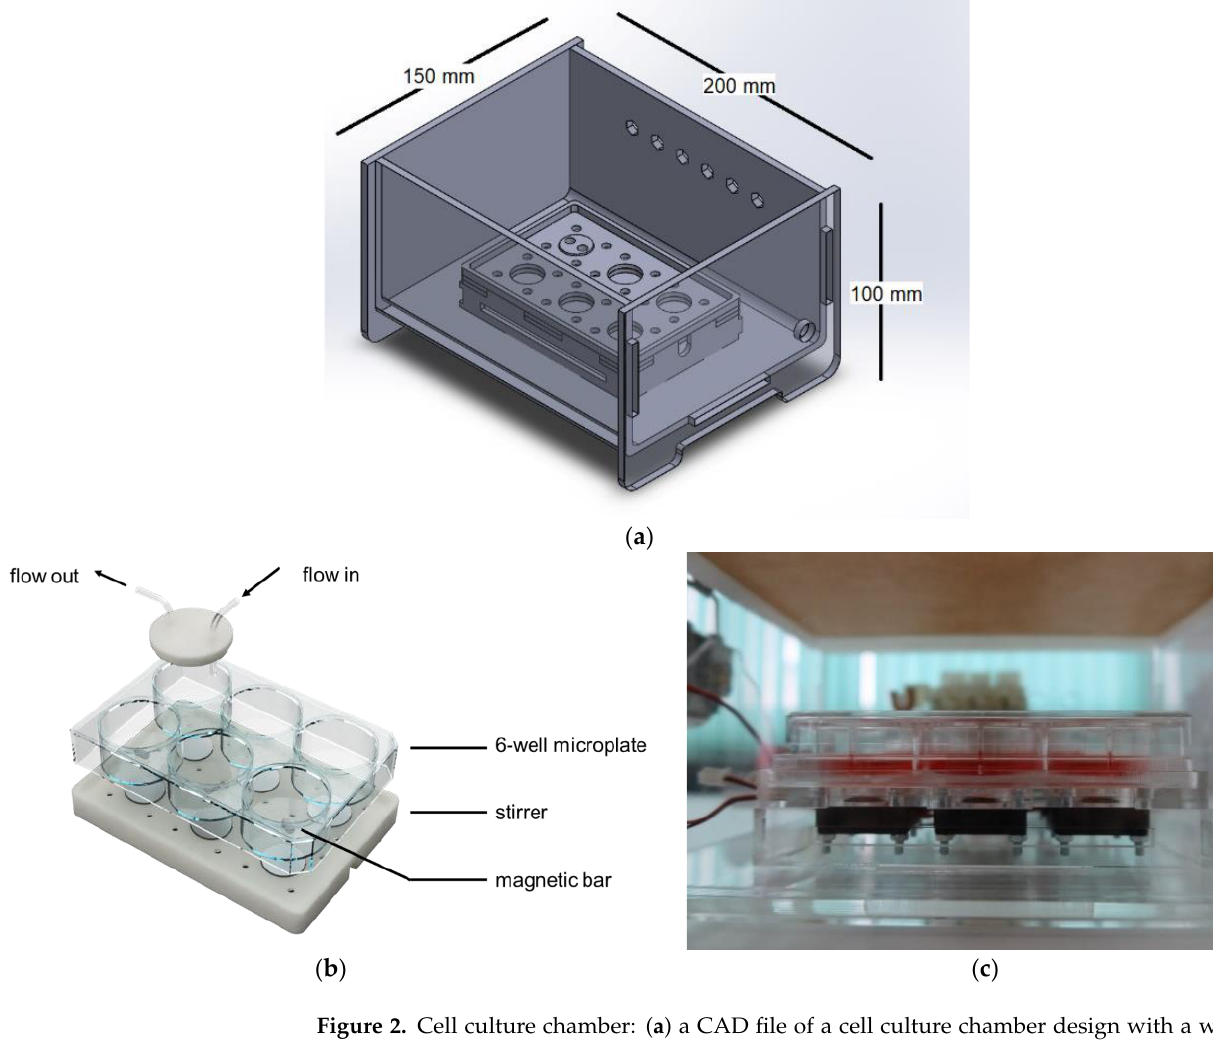
Figure 2. Cell culture chamber: ( a ) a CAD file of a cell culture chamber design with a well plate holder; ( b ) a CAD file showing 6-well plate with PDMS lids and 6 micro-stirrers; ( c ) a side view of a cell culture on a 6-well plate inside a cell culture chamber.